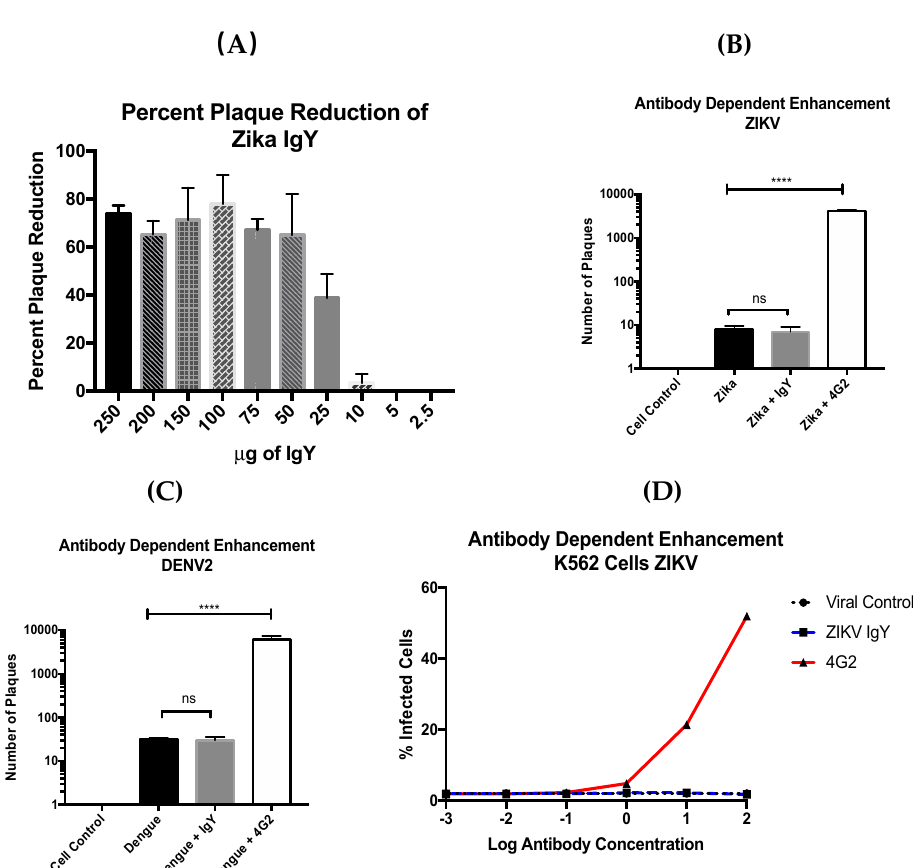
Figure 2. Anti-ZIKV IgY neutralizes ZIKV in vitro without antibody-dependent enhancement. ( A ) Anti-ZIKV IgY neutralized the ZIKV infection in vitro with a NT 50 of 25 µg/mL. ( B ) Purified anti-ZIKV IgY did not enhance the ZIKV infection in vitro at 100 µg/mL. ( C ) Purified anti-ZIKV IgY did not enhance the DENV2 infection in vitro at 100 µg/mL, whereas 4G2 flavivirus IgG significantly enhanced the viral load. ( D ) Purified anti-ZIKV IgY did not enhance the ZIKV infection in vitro at any level tested, whereas 4G2 flavivirus IgG significantly enhanced the viral load at 1, 10, and 100 µg. **** p < 0.0001, ns = not significant.